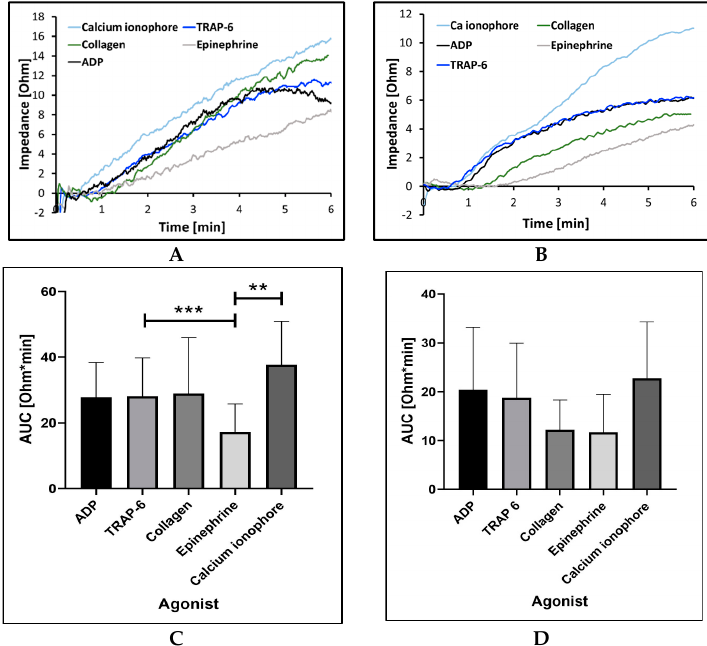
Figure 4. Platelet aggregation induced by different agonists in hirudin-anticoagulated whole blood ( A , C ) and platelet-rich plasma ( B , D ): AUC—area under the curve. ( A , B ) Illustrative aggregation curves recorded by the MICELI in whole blood and PRP, correspondingly. Data from 5 independent experiments using blood samples from 5 different individuals are reported. Mean ± SD as error bars of AUC are indicated, ANOVA: no asterisk– p > 0.05; ** p < 0.01, *** p < 0.005. To evaluate precision of the MICELI aggregometer, we calculated coefficient of variation (CV) of aggregation values obtained in whole blood and PRP using platelet agonists inducing consistent platelet aggregation, i.e., ADP, TRAP-6, collagen, and calcium ionophore. Thus, interdonor variability was evaluated as CV of aggregation parameters measured across three different donors having similar platelet count and hematocrit levels. Intradonor variability was calculated as CV of aggregation parameters measured for the same donor within the same experiments. The MICELI device demonstrated decent precision as indicated by inter- and intradonor variability of AUC values (Table 1). Both inter- and intradonor variability of the aggregation parameters was significantly lower in PRP than in whole blood for all agonists tested. ADP and TRAP-6 showed lower CV for both inter- and intradonor distribution in PRP and whole blood, while collagen exhibited higher level of variability in whole blood than in PRP. Calcium ionophore-induced aggregation was characterized by good reproducibility regardless of the platelet sample type across all donors tested. Table 1. Precision of the MICELI aggregometer using different platelet agonists as indicated by intra- and interdonor variability of area under the curve (CV, %). Intradonor Variability 1